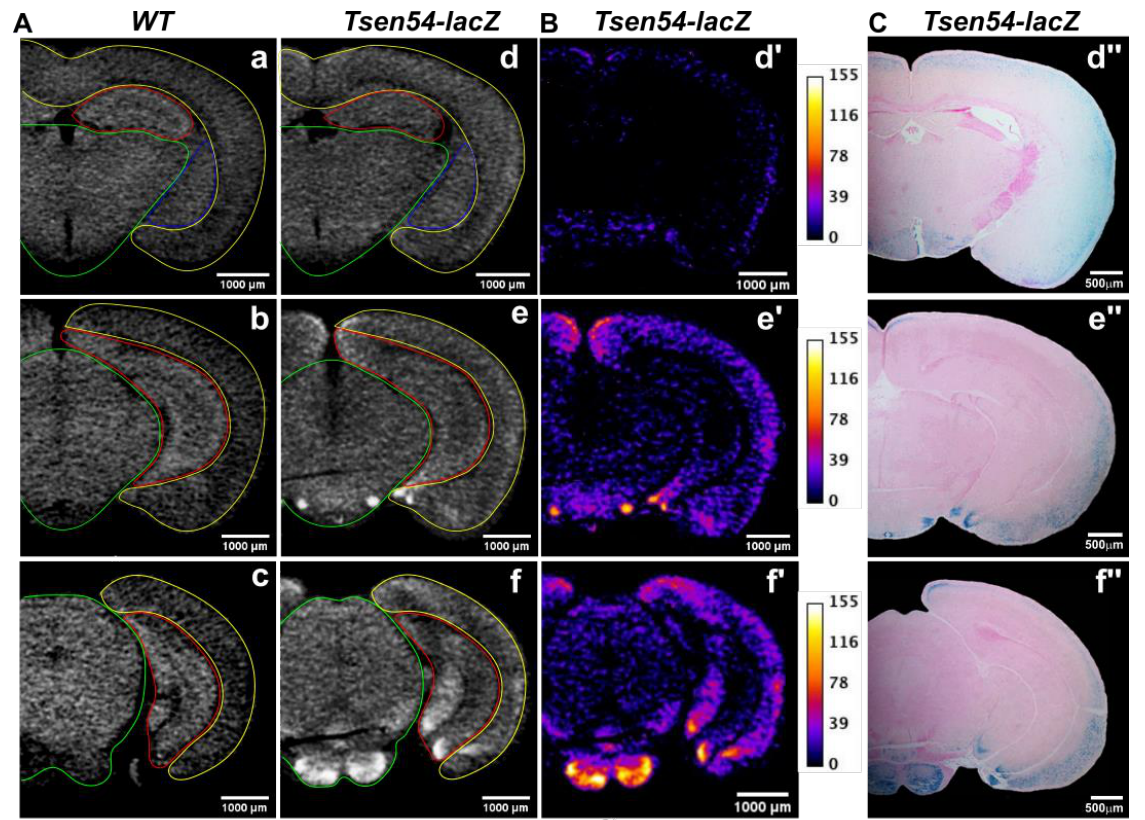
Figure 2. Comparison of virtual X-ray sections to histological sections of Tsen54-lacZ cerebrum reveals X-ray-detected regions of reporter gene expression. ( A ) Two-dimensional micro-CT-derived sections from cerebrum of wild type ( a – c ) and Tsen54-lacZ ( d – f ) animals. ( B ) Segmentation analysis of the virtual micro-CT-derived sections from Tsen54-lacZ brains ( d ′– f ′ ). The lines delineate the segmentation regions: yellow—cortex; red—hippocampal plate; blue—amygdala; green—central brain. The Lookup Table (LUT) function was set from a 0 to 155 grayscale value interval. ( C ) Corresponding histological sections from the Tsen54-lacZ brain whole-mount stained with X-gal and counterstained with eosin solution ( d ′′ – f ′′ ). Micro-CT scans were performed with the resolution 20 m/voxel.